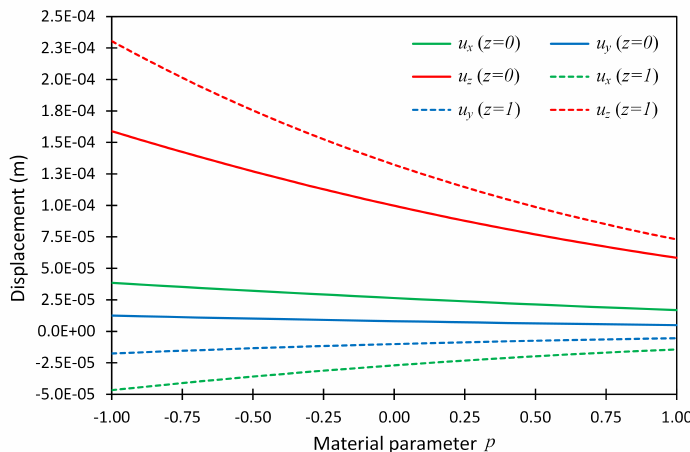
Figure 4. The displacement components at two locations ( x , y , z )=(0.75,0.75,0) and (0.75,0.75,1) versus material parameter p for Example 1 considering boundary conditions